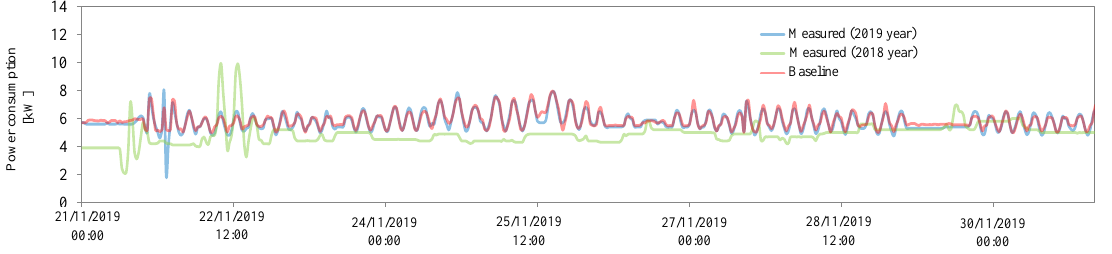
Figure16. Comparisonofactualpowerconsumptionsin2018and2019andbaselinepowerconsumption Figure 16. Comparison of actual power consumptions in 2018 and 2019 and baseline power of consumption of CRAC.